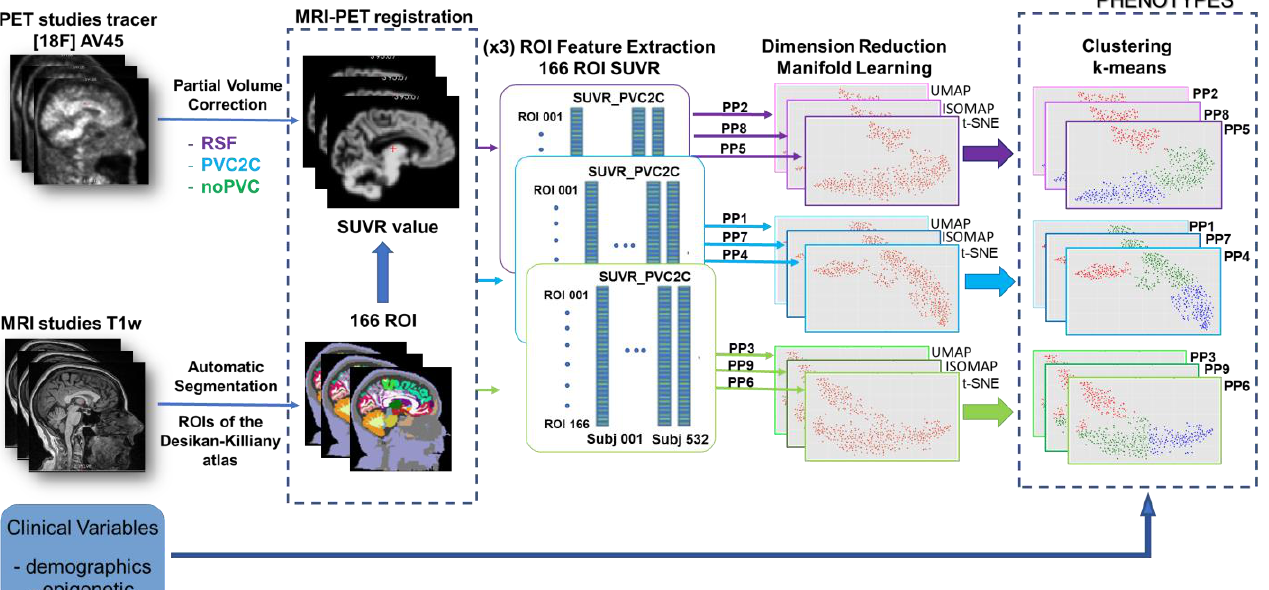
Figure 2. General schema for the method presented in this paper. Two different imaging modalities Positron Emission Tomography (PET) and Magnetic Resonance Imaging (MRI) are employed to extract the set of 166 Regions of Interest (ROIs). The ROIs are dimensionality-reduced by different methods (colored in green, blue, and purple lines in the schema), which will permit them to be clustered in the final stage to extract the phenotypes.